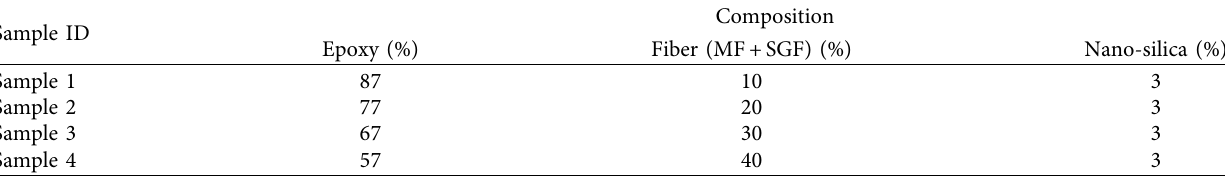
Table 2: Composition of fabricated samples.